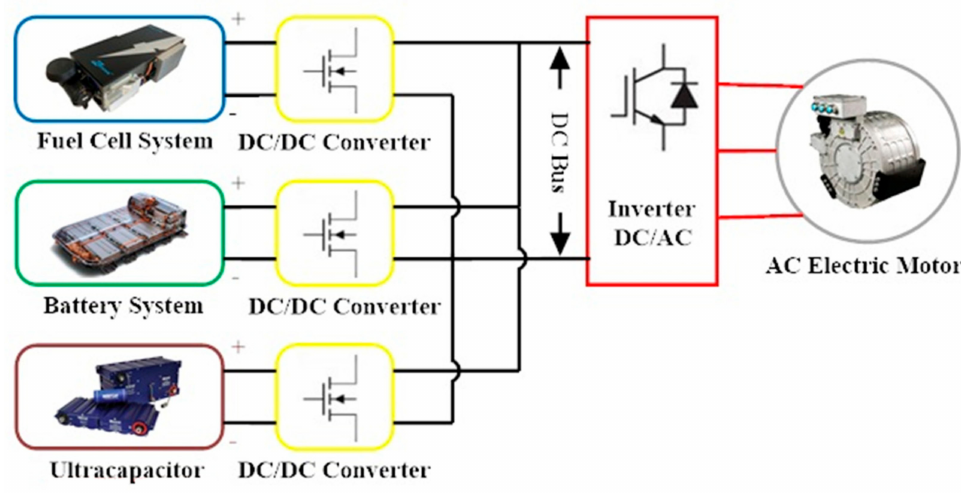
Figure 2. Configuration of a fuel cell hybrid electric vehicle (Topology